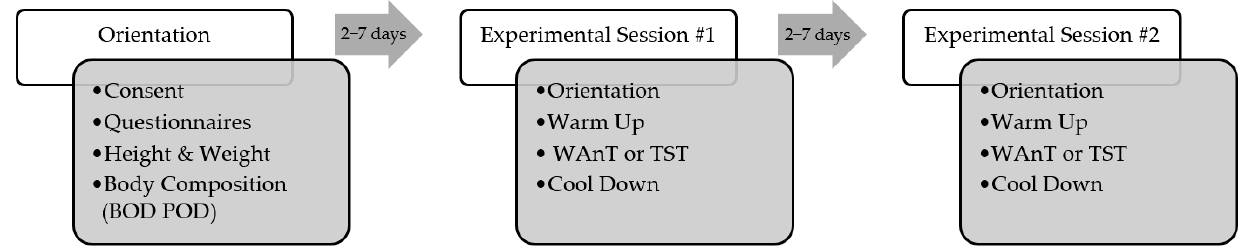
Figure 1. Experimental design scheme.